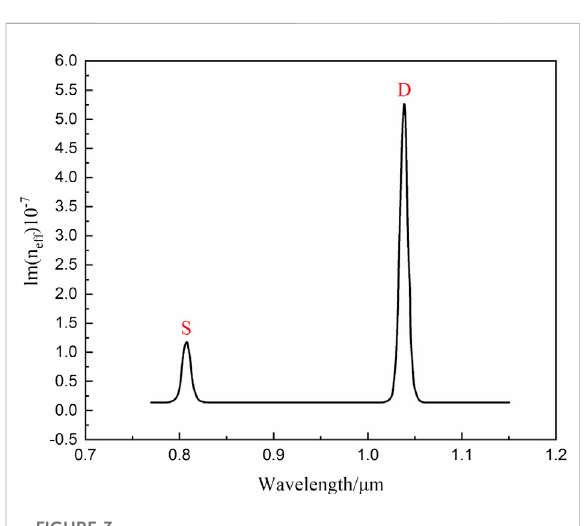
FIGURE 3 The loss curves of SPR and directional coupling channels.